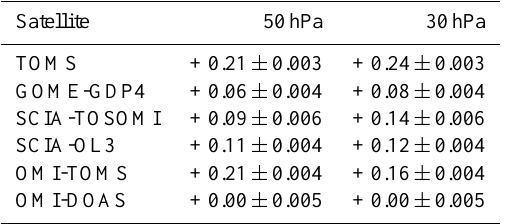
Table 7. Temperature dependence of satellite-SAOZ V2 relative difference at 50 and 30hPa (in %/ ◦ C).